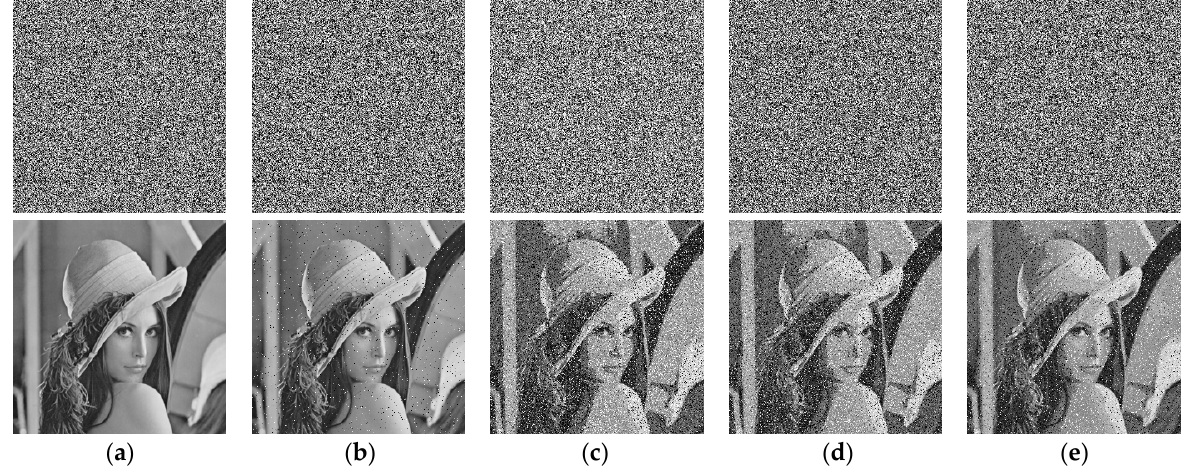
Figure 20. Encrypted "Lena" image and its decrypted versions after: ( a ) 0 % noise addition, ( b ) 3% salt and pepper, ( c ) 3% Gaussian noise, ( d ) 3% speckle noise and ( e ) Poisson noise.